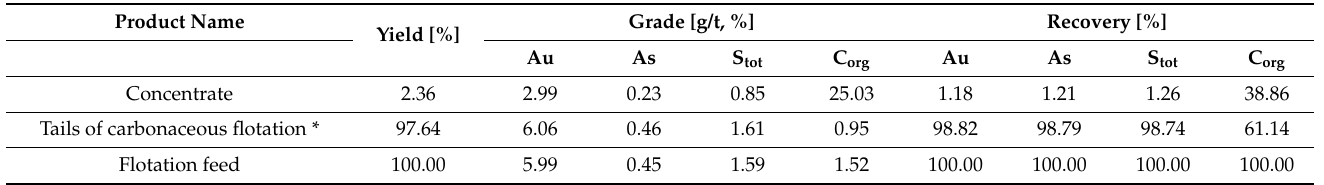
Table 14. Carbonaceous flotation CGO